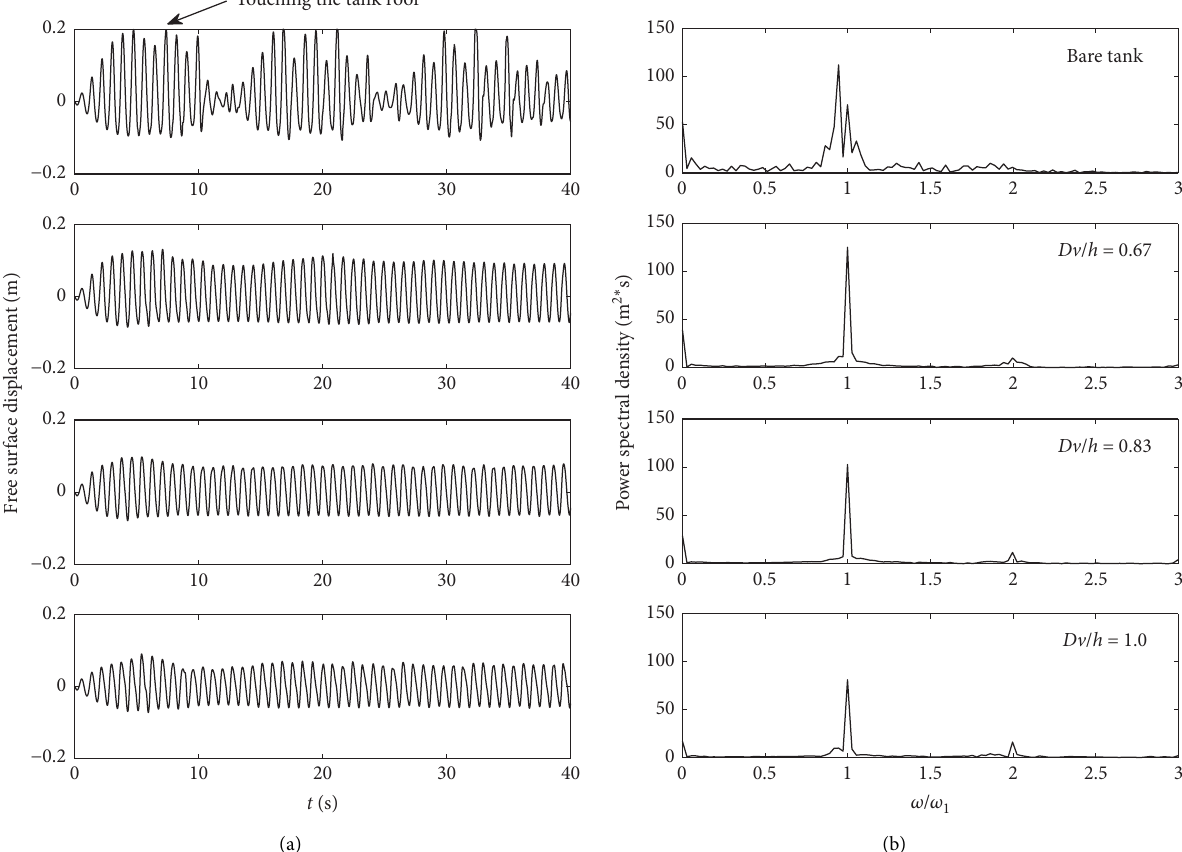
Figure 6: (a) Numerical free surface displacement and (b) the corresponding power spectra at Gauge 1 for different vertical baffle heights.